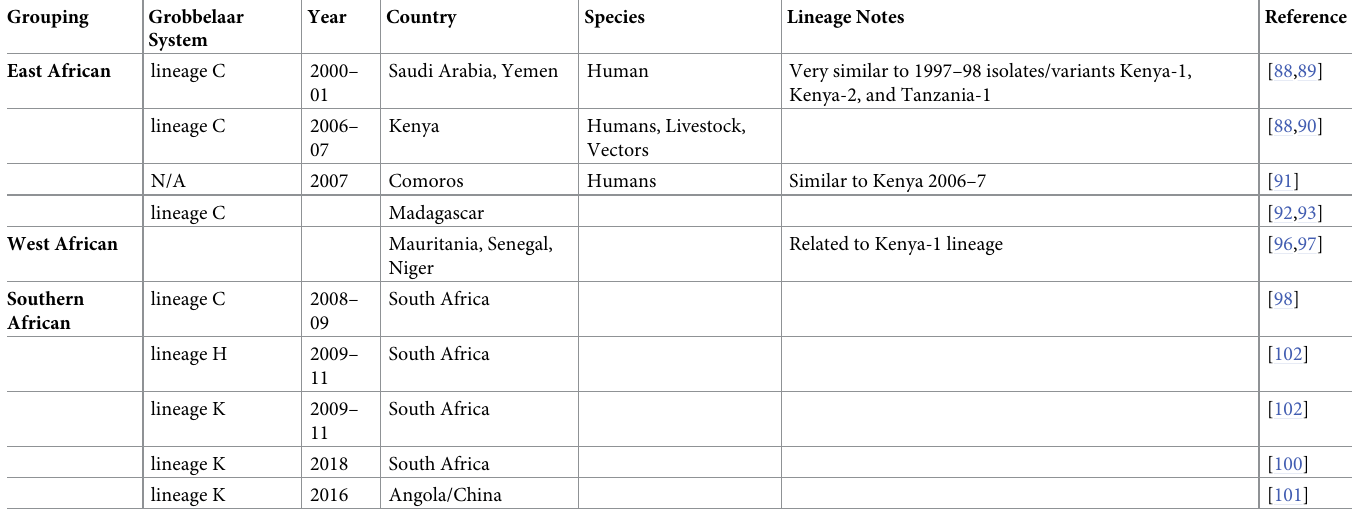
Table 2. Rift Valley fever virus lineage determinations for isolates recovered in recent epidemics, based on cluster analysis of gene sequences for the viral Gn surface protein. (Based on Grobbelaar, et al. 2011 [98]) Grouping